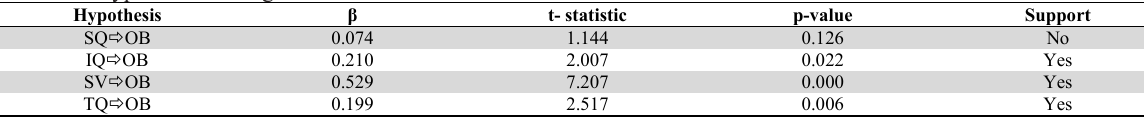
Results of hypotheses